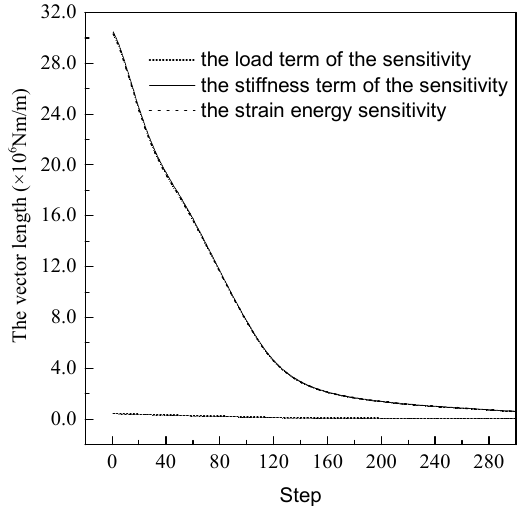
Figure 16. The vector length of the load term, the stiffness term and the whole value of the structural strain energy in Scheme A.